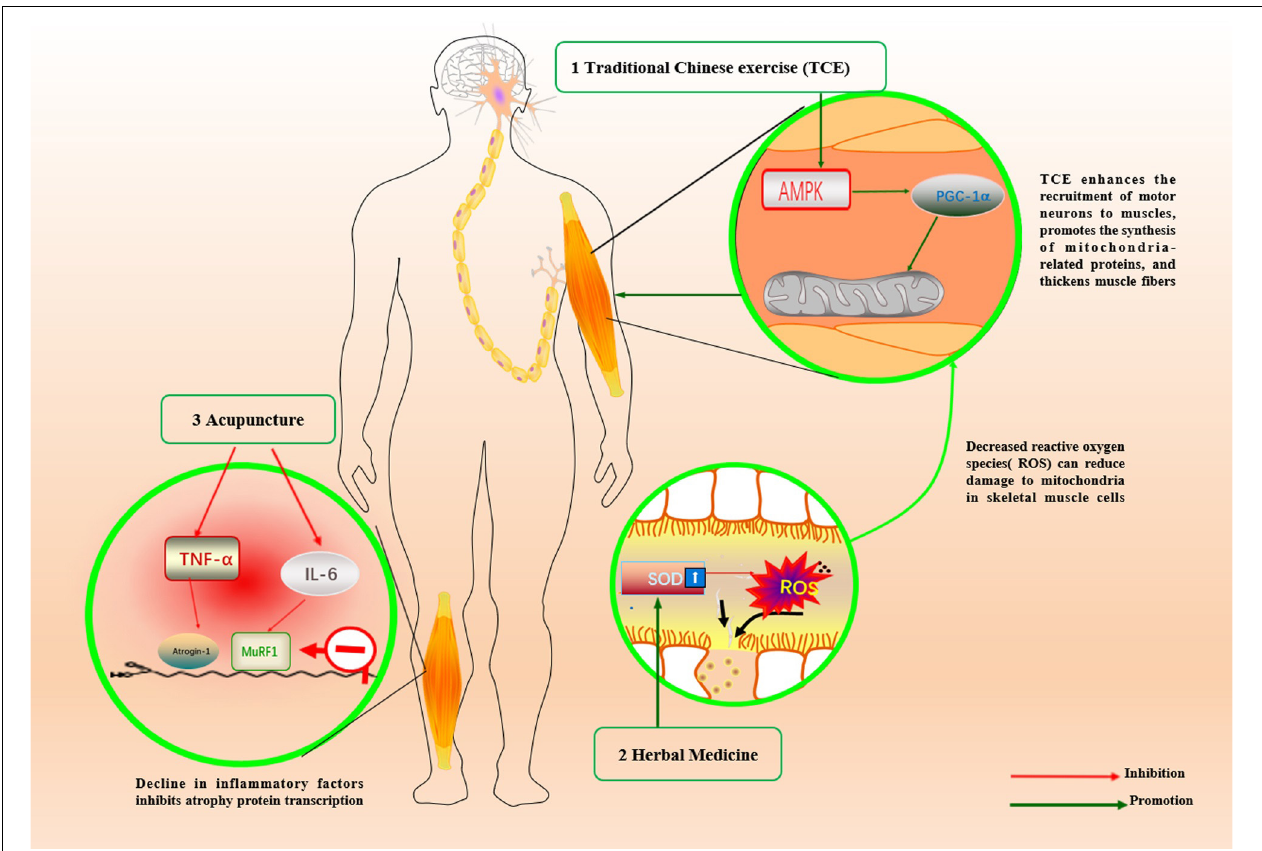
FIGURE 2 | Mechanism of traditional Chinese medicine in the treatment of